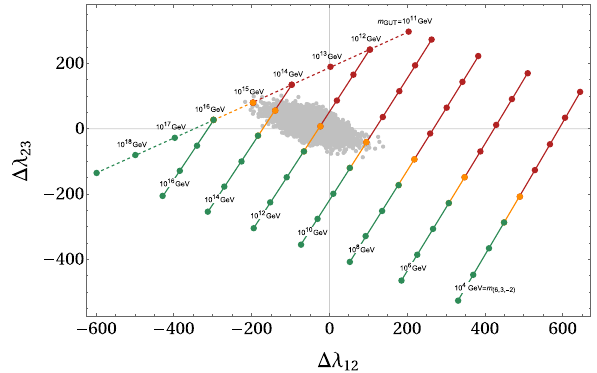
Fig. 8 Prospects for gauge unification in scenarios with light ( 6 , 3 , − 2 ) scalars.Themaximumvalueforthe SO ( 10 ) scale M max